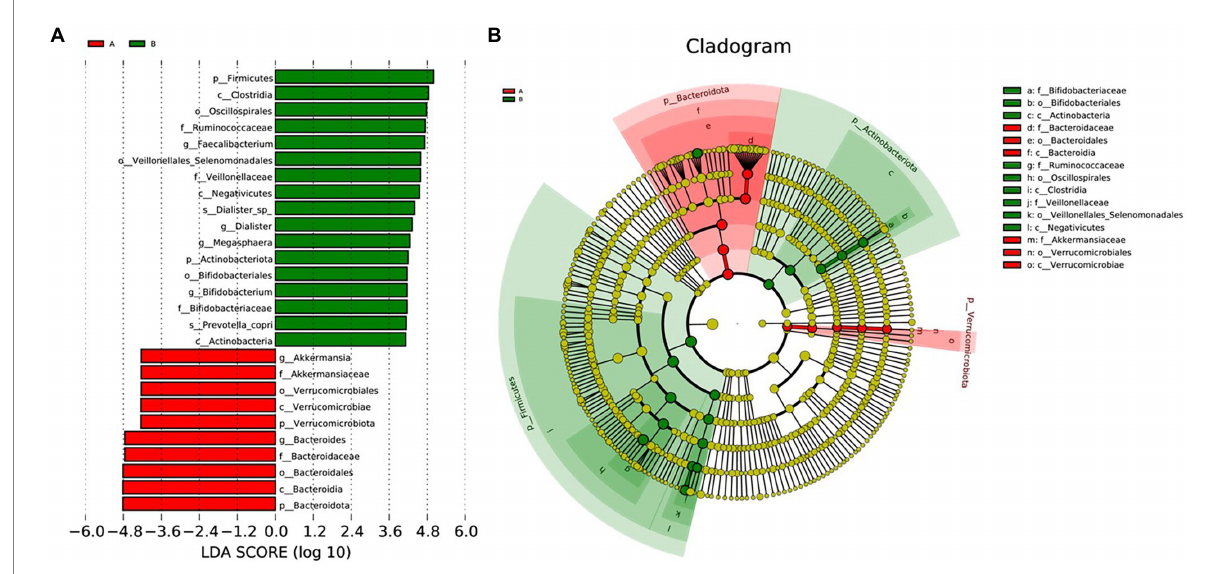
FIGURE 4 LEfSe analysis. (A) , Histogram of LDA Score distribution. The difference of species abundance between two groups. (B) , Cladogram. The phylogenetic distribution of GMB associated with two groups. The circle radiating from inside out represents the rank of classification from phylum to